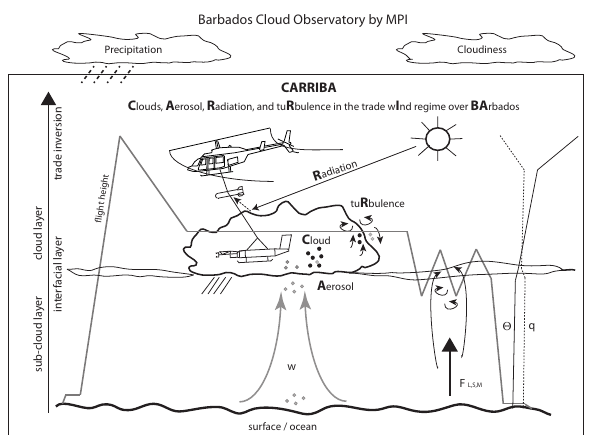
Fig. 1. The cartoon illustrates the cloud processes of the four main topics of the CARRIBA project: Clouds, Aerosol, Radia- tion, and tuRbulence in trade wInd regime over BArbados and how the helicopter-borne measurements are embedded in the long-term remote-sensing observations in terms of cloudiness and precipita- tion performed at the Barbados Cloud Observatory